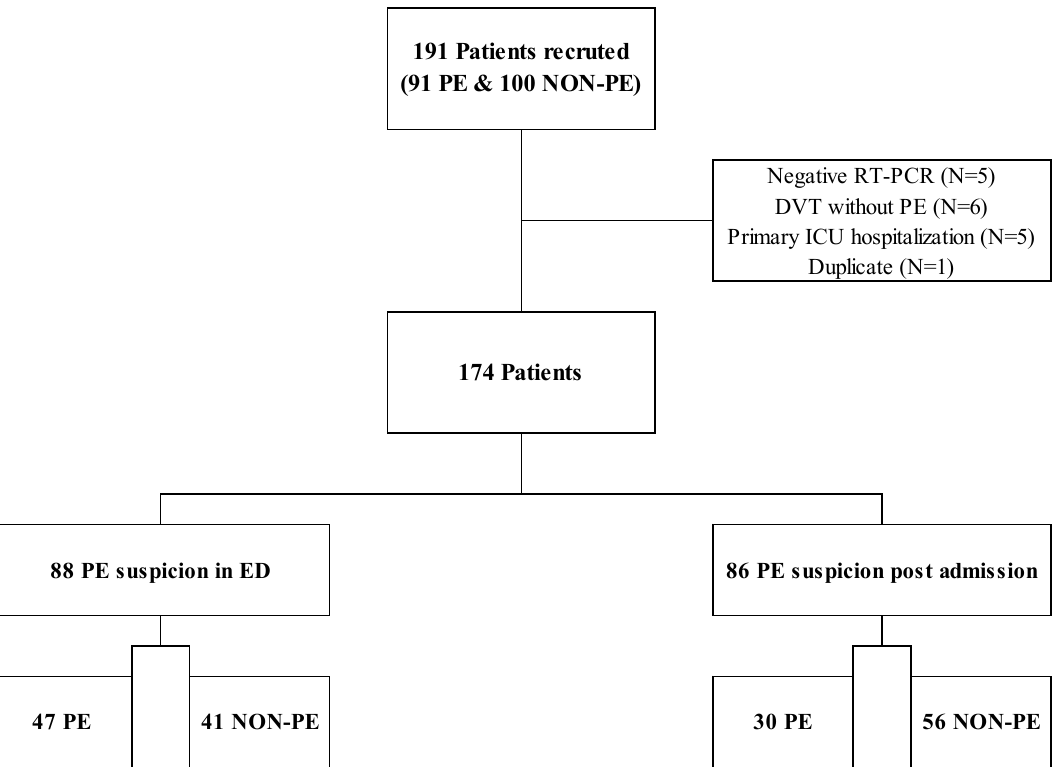
Figure 1. CLOTVID study flowchart diagram for patients hospitalized in medicine wards and with pulmonary embolism suspicion ≥ 24 h after admission. DVT, deep venous thrombosis; ED, emergency department; ICU, intensive care unit; PE, pulmonary embolism; NON-PE, absence of PE; RT-PCR, reverse transcriptase-polymerase chain